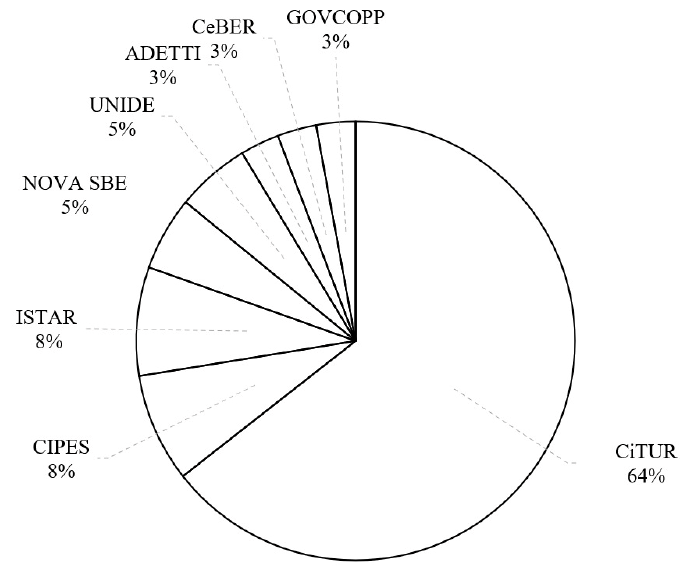
Figure 7. Research centers’ ranking.